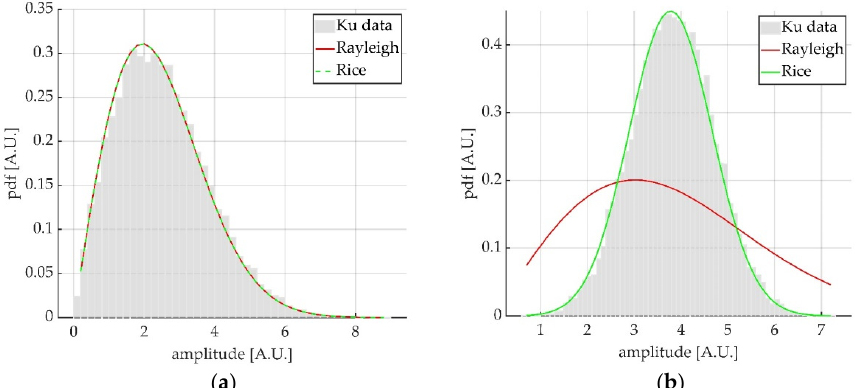
Figure 1. Comparison between amplitude histograms and theoretical distributions for simulated data: ( a ) represents the model where only random scatterers are present; in ( b ) both random and fixed scatterers are present. The red curve is the Rayleigh function resulting from the fitting of simulated data, while the green curve is the Rice function. For each time series, the coherence and the D (cid:2885) were computed. The coherence was